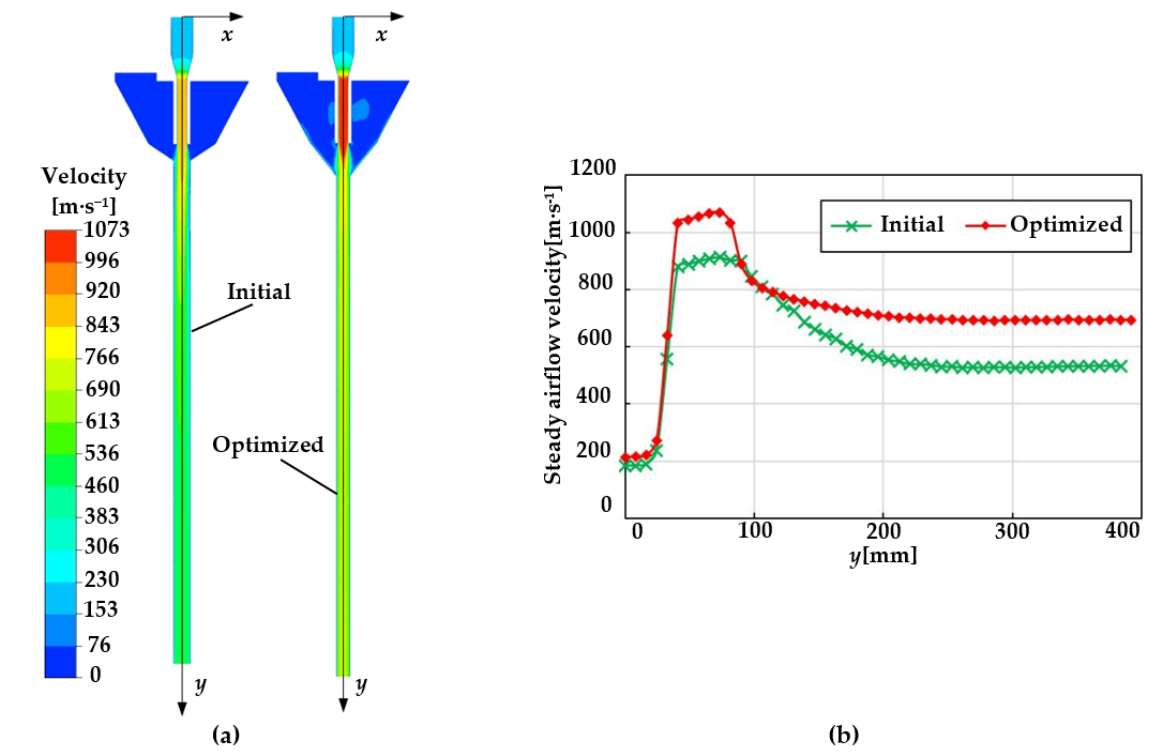
Figure 5. ( a ) Velocity field of initial and optimized. ( b ) Velocity curve of initial and optimized.